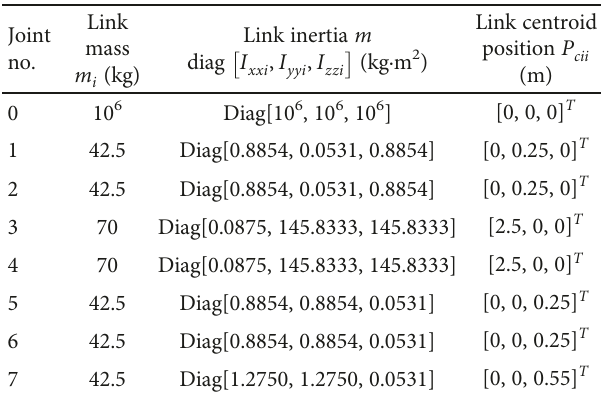
Table 2: Dynamic parameters of SSRMS-type 7 DOF space